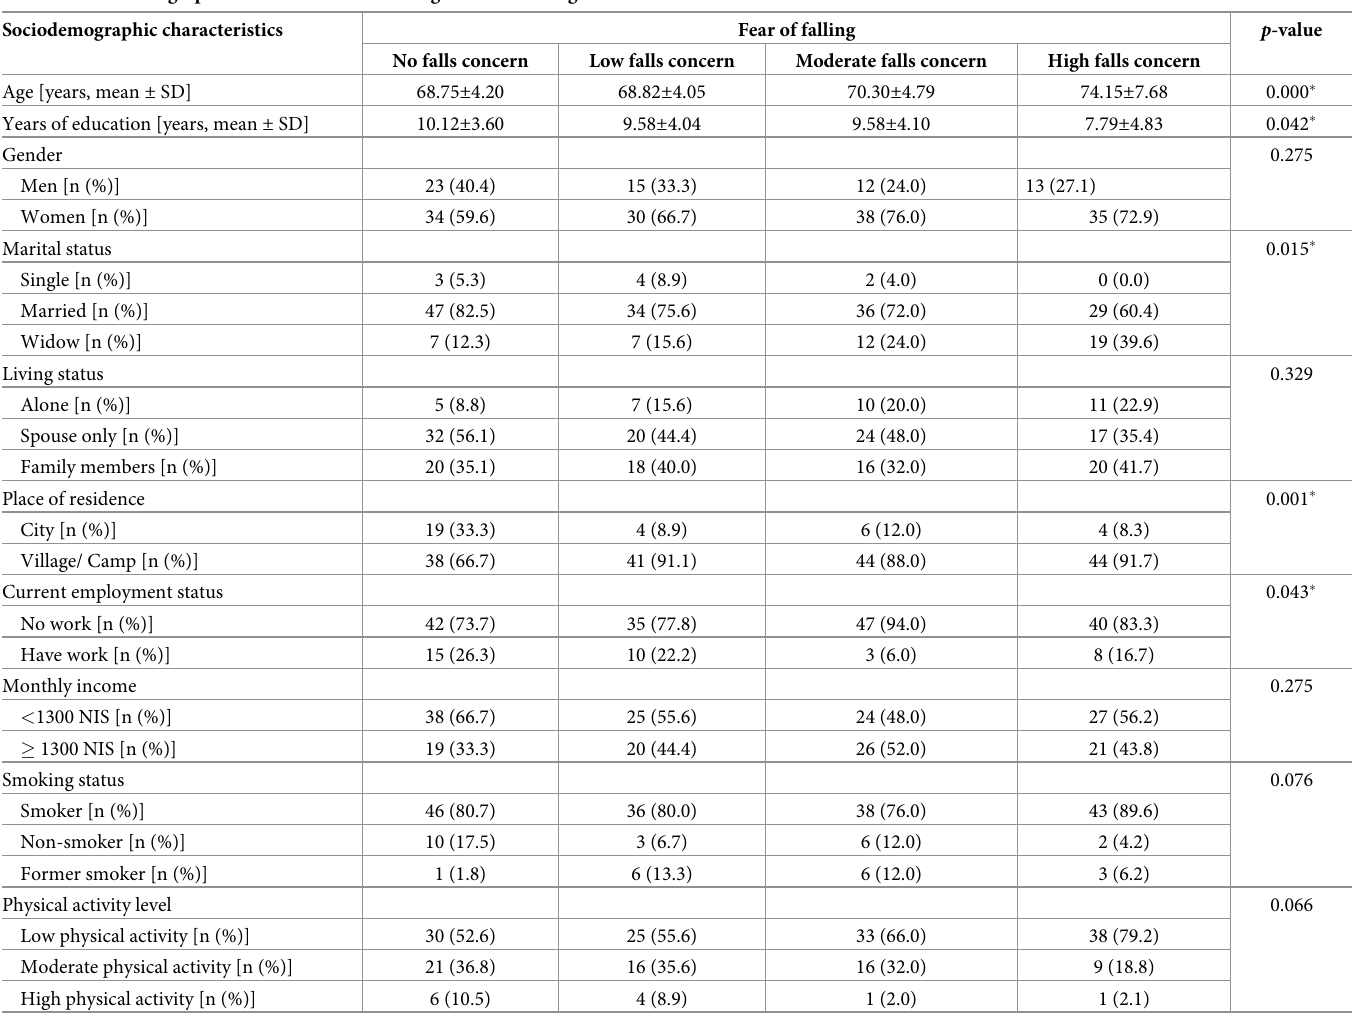
Table 3. Sociodemographic characteristics according to fear of